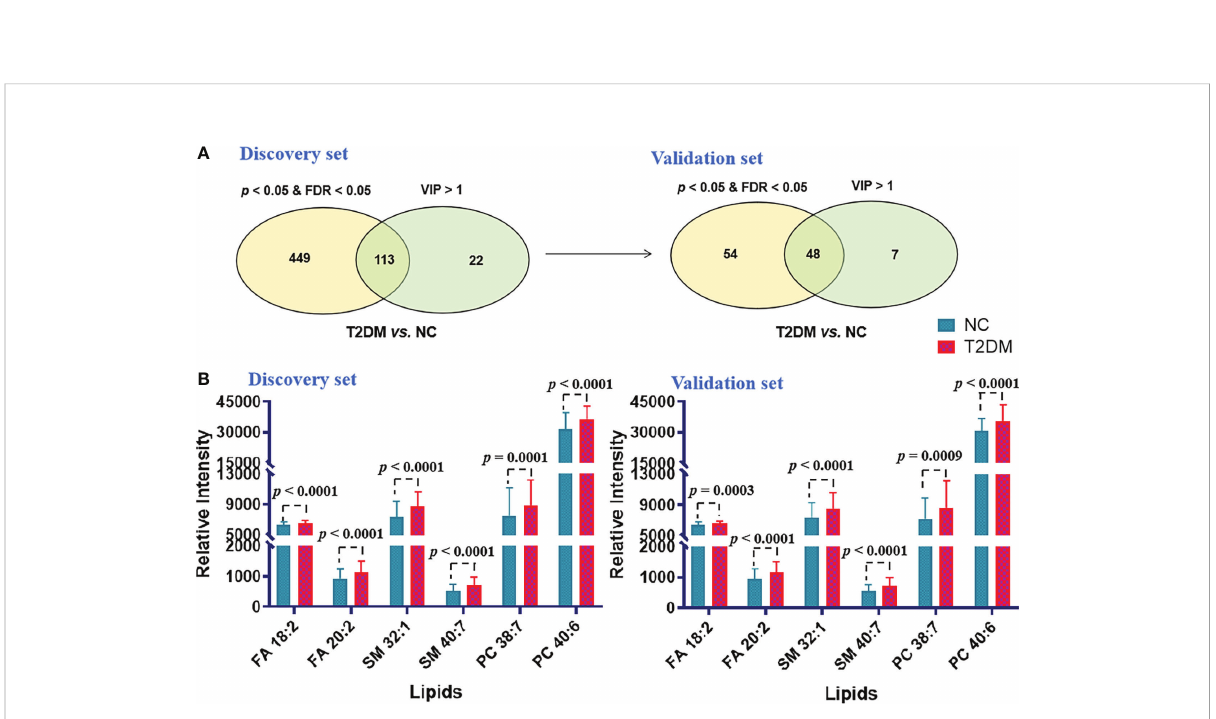
FIGURE 4 (A) Venn diagram of signi fi cantly differential lipids based on NC and T2DM. (B) Histograms of potential lipid markers in NC and T2DM specimens. Data are presented as mean ±